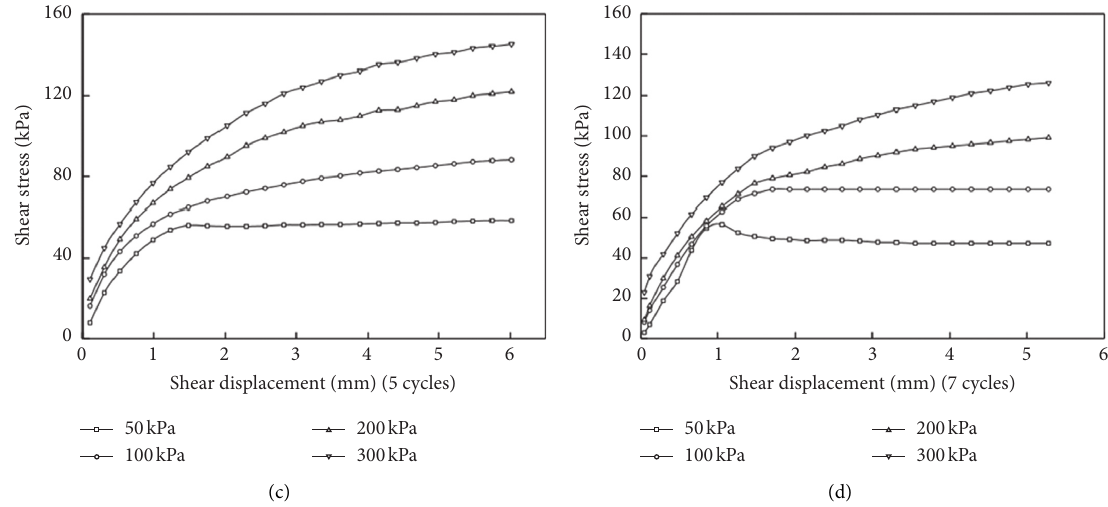
Figure 7: Straight shear test curve of red clay under different dry and wet cycles ( ρ